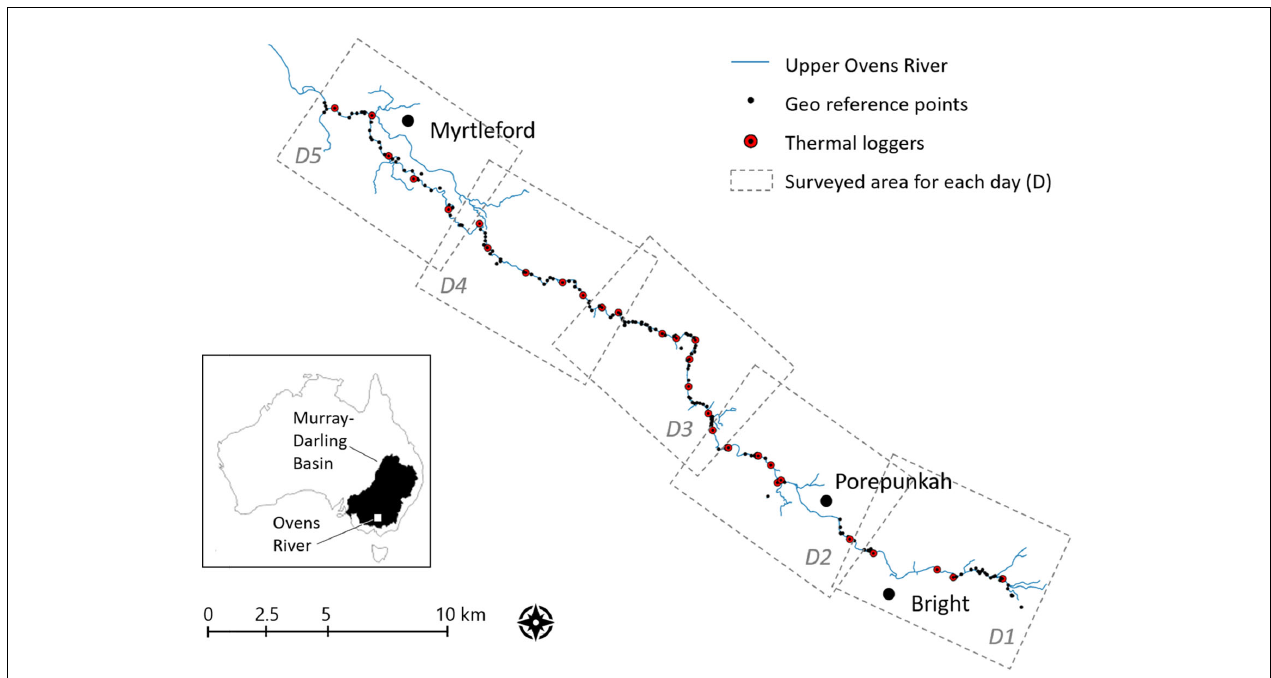
FIGURE 1 | Location of the Upper Ovens River with the position of all Ground Control Points (GCPs) and thermal references, and the delimitation of the areas surveyed each day (D).